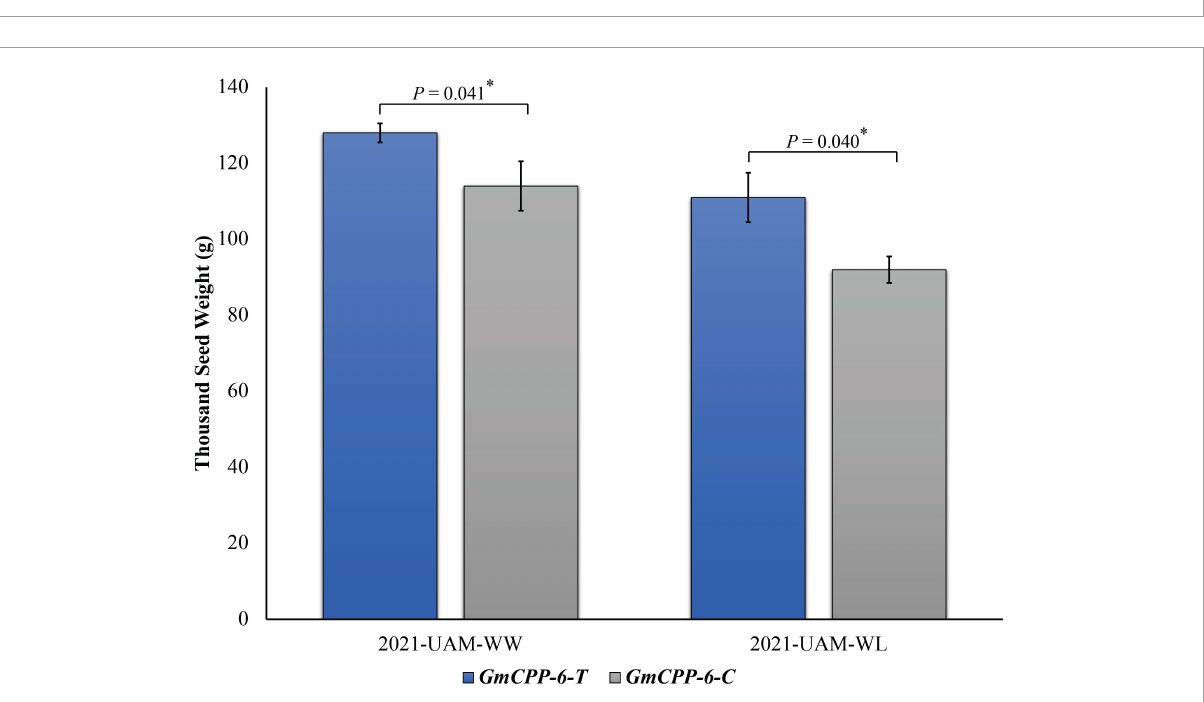
FIGURE7 Phenotypic comparison of GmCPP-6 allelic variations under well water (WW) and water limited (WL) conditions. The two environments were at University of Agriculture Multan (UAM) under WW and WL conditions in year 2021. * p less than 0.05. Error bars denote standard